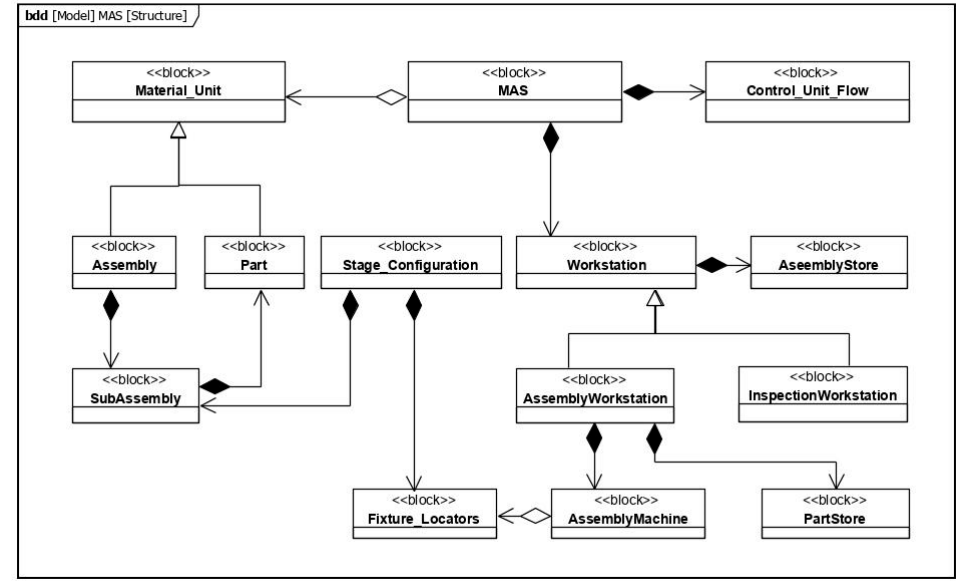
Figure 2. Block definition diagram for the generic MAS structure.